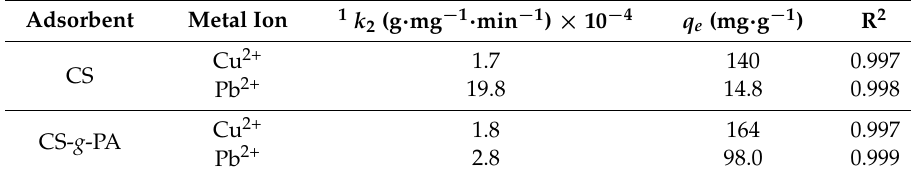
Table 3. Model kinetic parameters for removal Pb 2+ and Cu 2+ by CS and CS- g -PA.